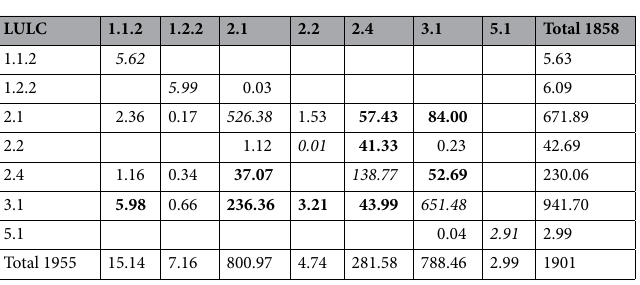
Table 6. LULC change matrix between 1858 and 1955 in the Aksu region (areas in hectares). Significant values are in [bold, italics].